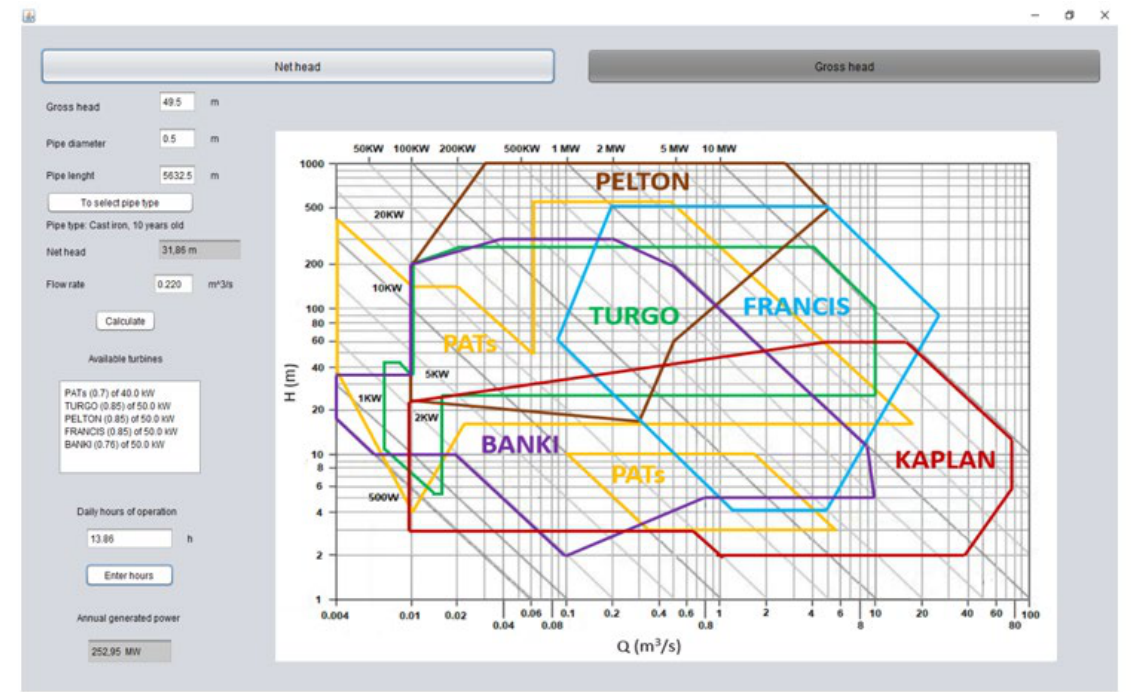
Figure 4. Main window of the computer application developed: results of case study 2.